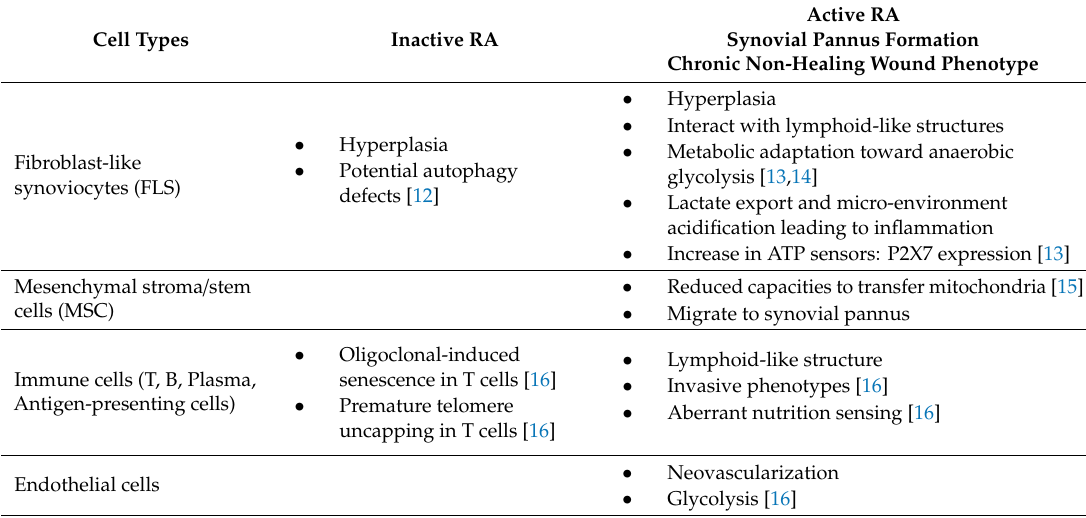
Table 1. Cell-type interactions and synovial pannus